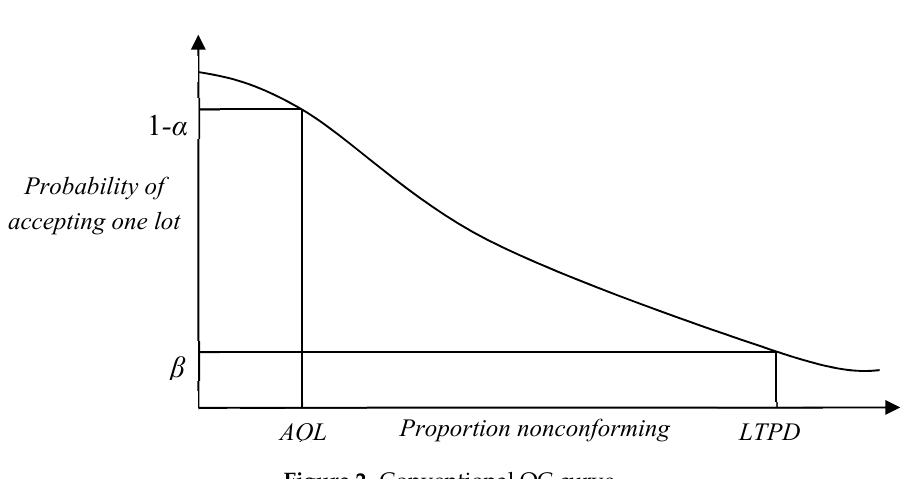
Figure 2. Conventional OC curve.